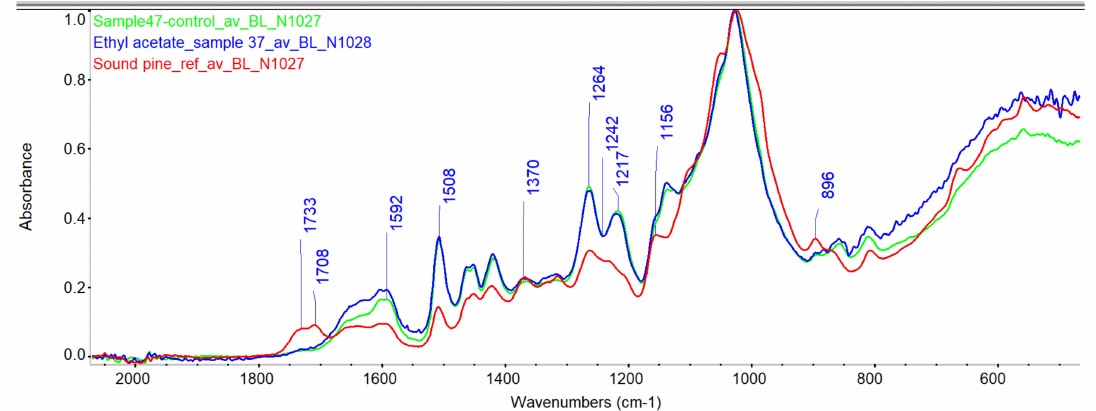
Figure 3. Infrared spectra of archaeological wood, untreated specimen nr. 47 (green curve), ethyl acetate-treated control nr. 37 (blue curve) and sound pine (red curve). Main differences are highlighted at indicated bands.